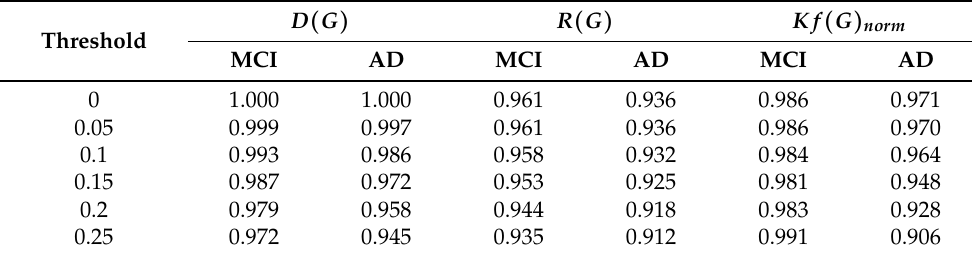
Table 5. Indexes’ performance comparison for the relevant threshold range.